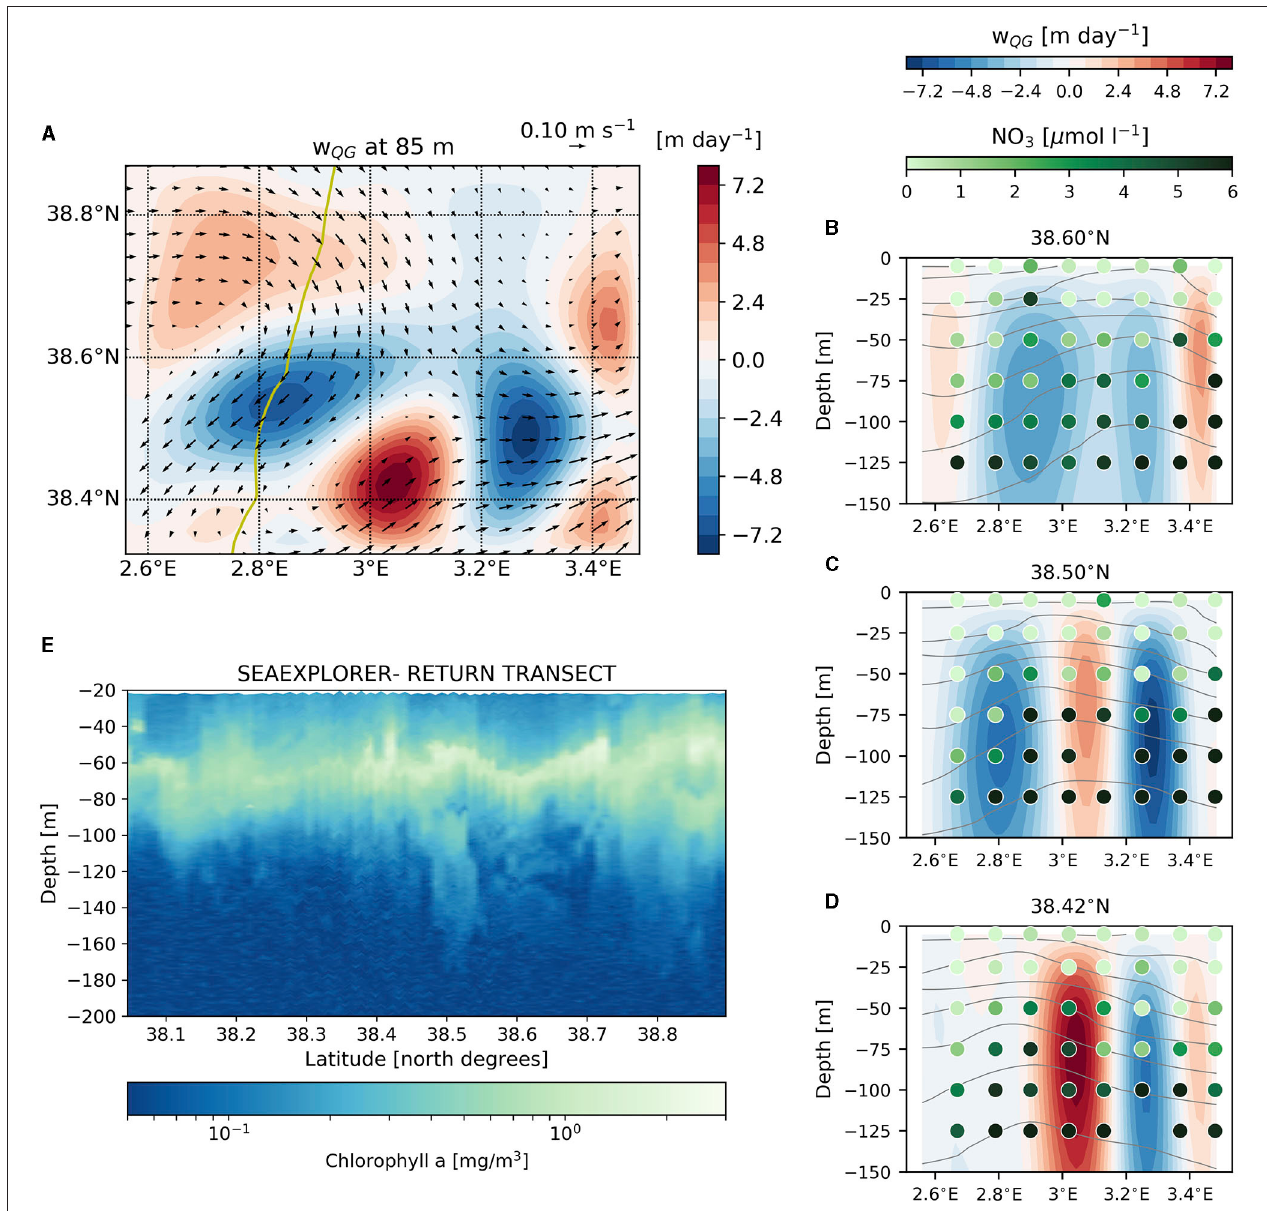
FIGURE 9 | (A) Map at 85 m depth of the QG vertical velocity field and geostrophic velocity vectors calculated from CTD data (for clarity, only one out of two current vectors are plotted). Green line represents the return trajectory of the SeaExplorer glider along which the chlorophyll-a concentration is shown in E . (B–D) Zonal sections of the QG vertical velocity field along (A) 38.60 ◦ N, (B) 38.50 ◦ N, and (C) 38.42 ◦ N with the nitrate concentration sampled at the closest stations along (A) 38.59 ◦ N, (B) 38.50 ◦ N, and (C) 38.41 ◦ N. Gray contours represent the potential density anomaly along the same sections as the QG vertical velocity (the contour at the bottom is the 28.8 kg m − 3 isoline and density decreases upwards with a contour interval of 0.2 kg m − 3 ). (E) Chlorophyll-a concentration derived from the SeaExplorer measurements along the return